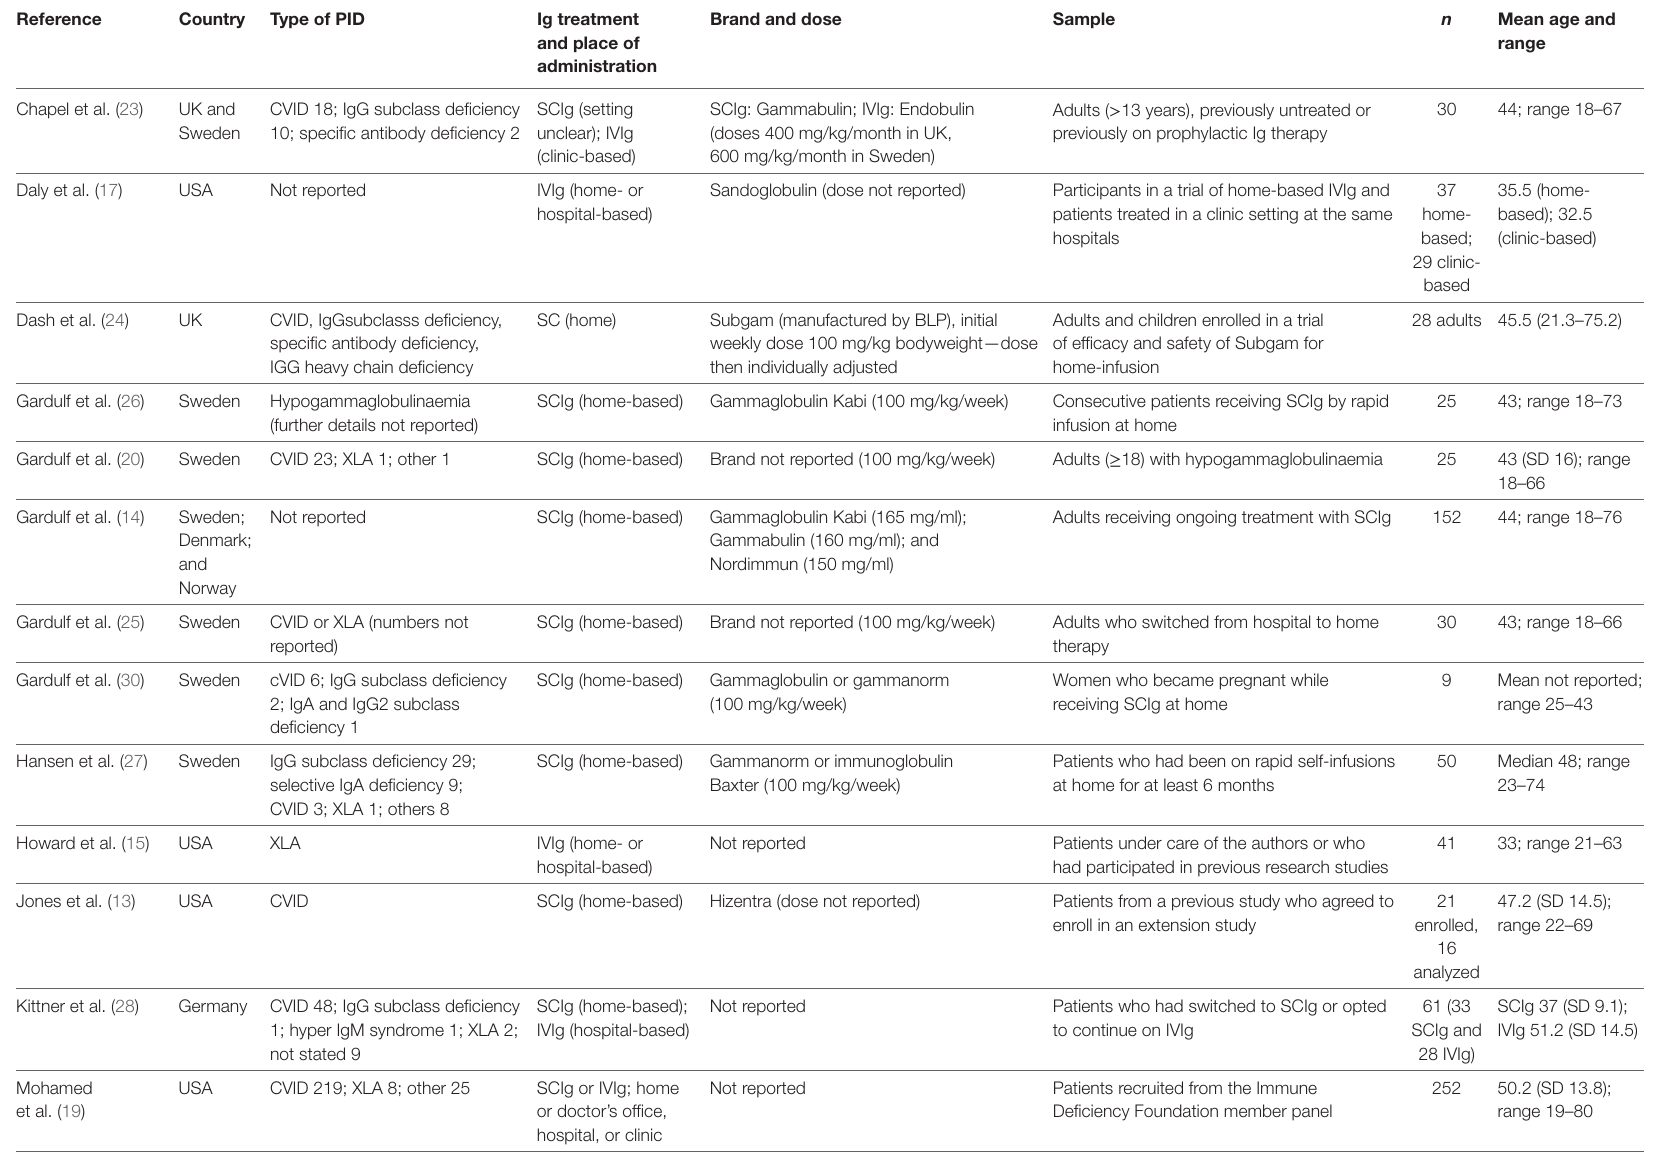
taBLe 3 | Clinical characteristics of included